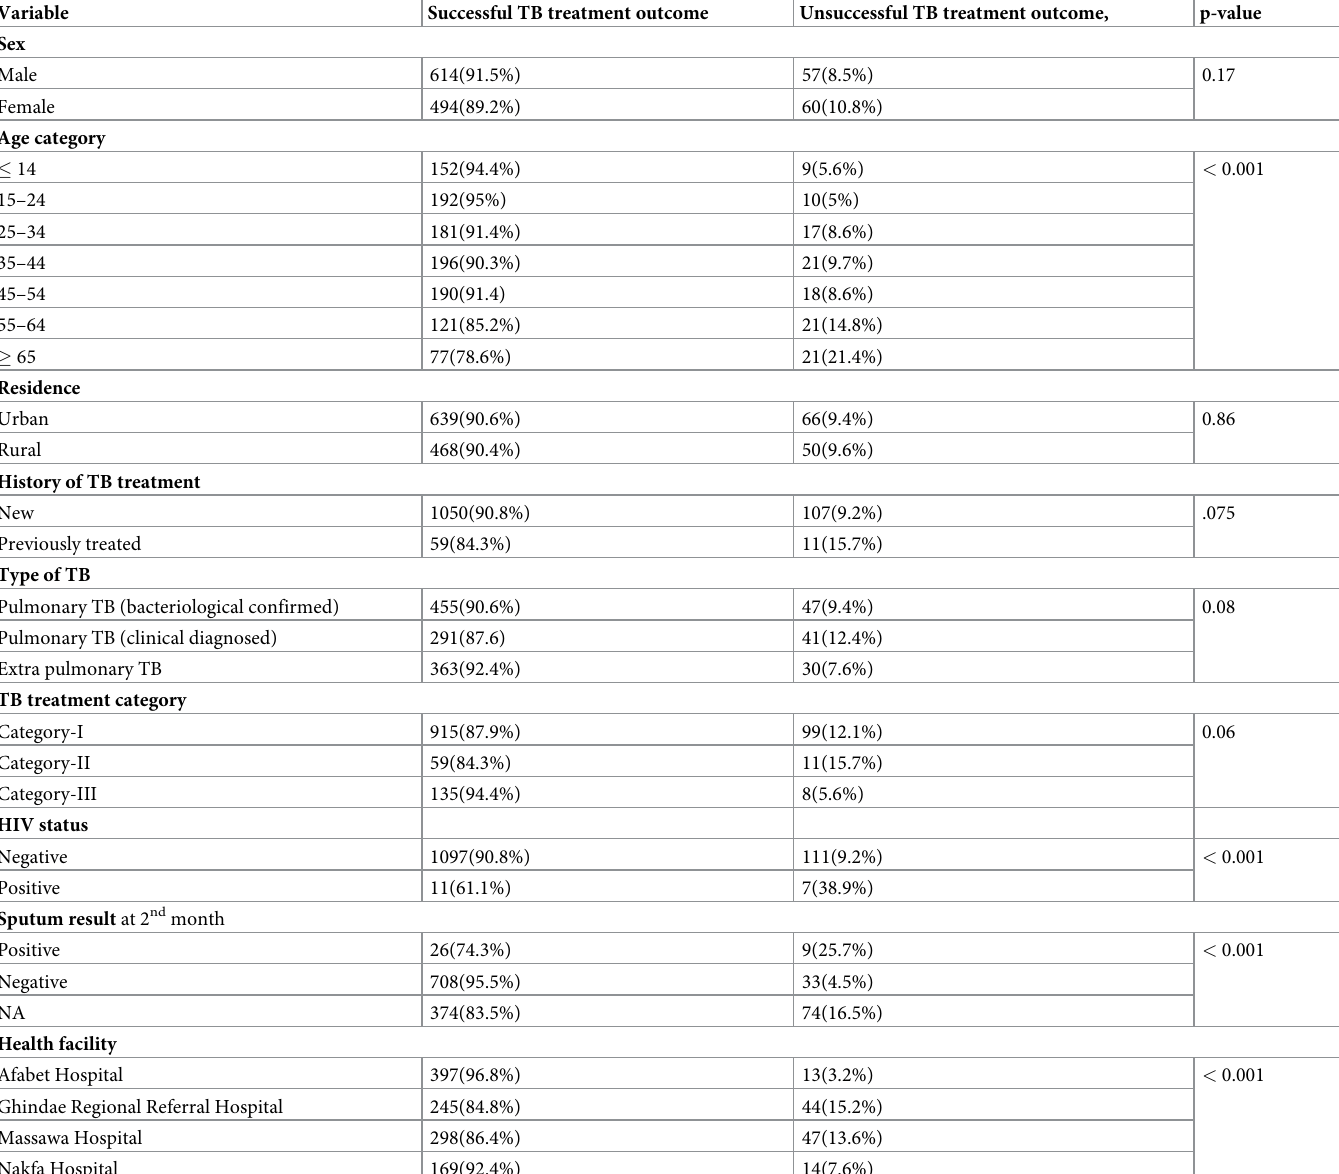
Table 2. Comparison among successful and unsuccessful TB treatment outcomes in Northern Red Sea region, 2014–2019 cohort (n =